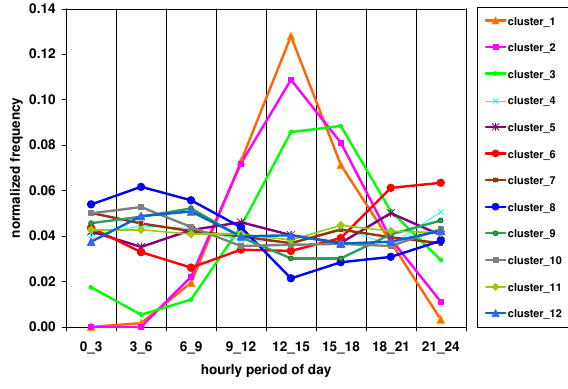
Fig. 5. Diurnal variation (3h resolution) of the 12